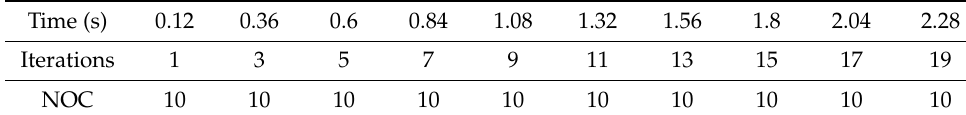
Table 9. Number of channels per 10 iterations (BTT).